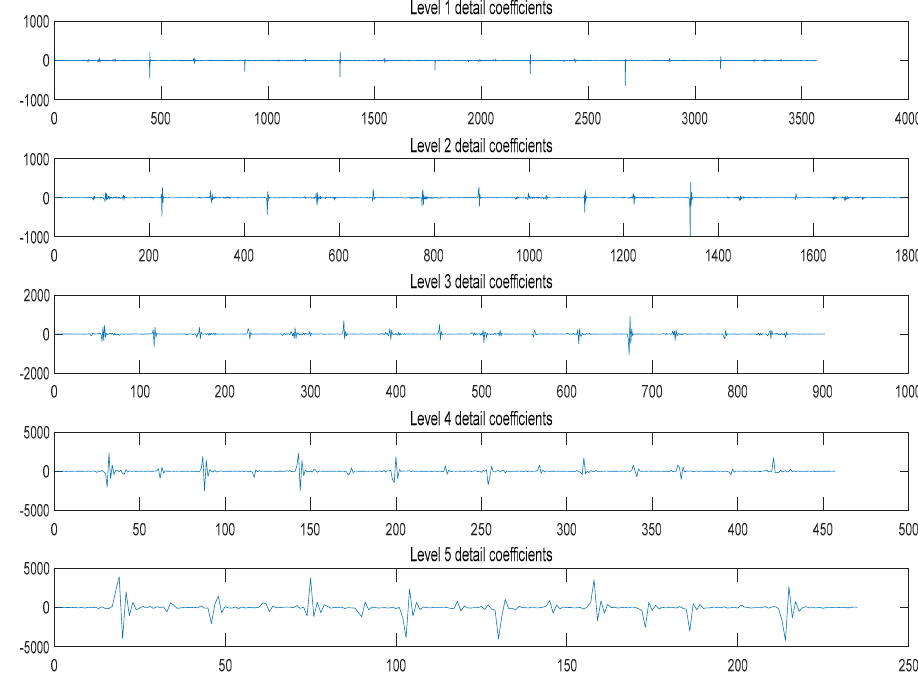
Figure 11. Detailed coefficient under different decomposition layers.